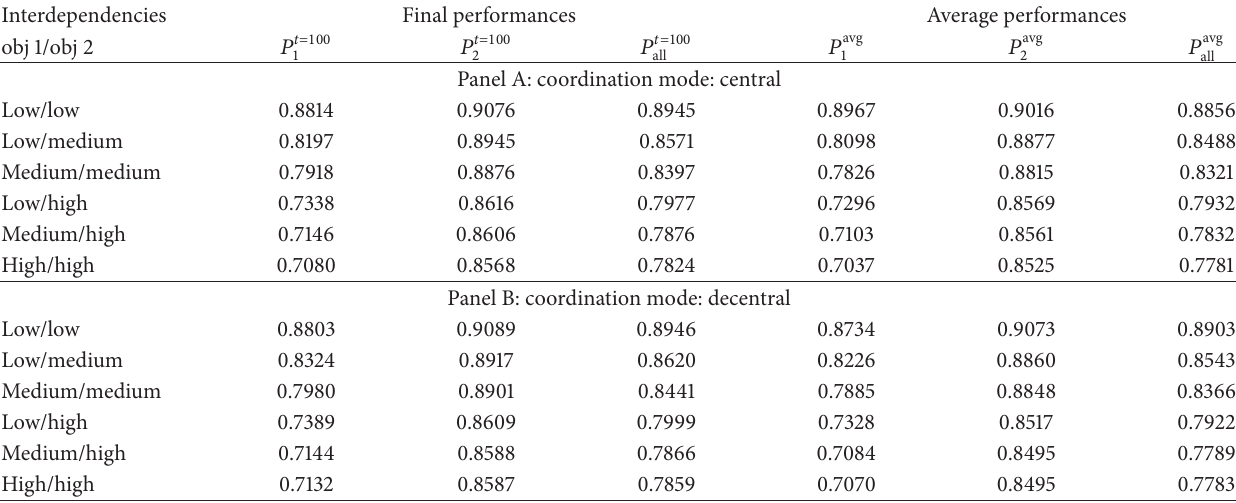
Table 3: Satisficing approach, aspiration level for objective 2: 𝑠 2 = 0.8